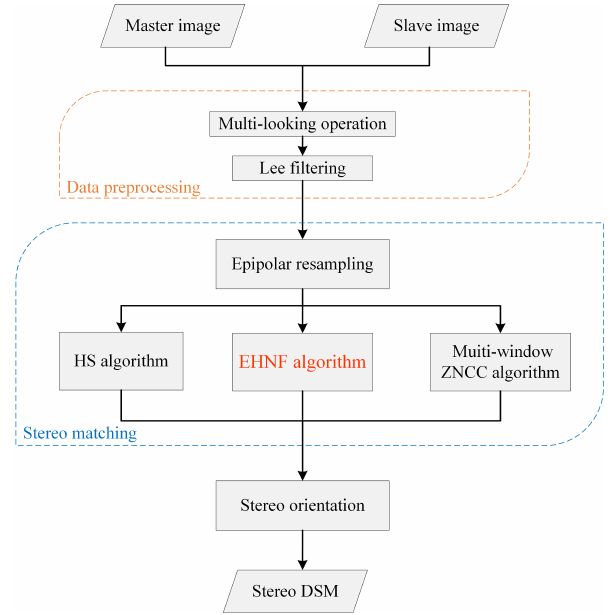
Figure 1. Flow chart for the radargrammetric DSM